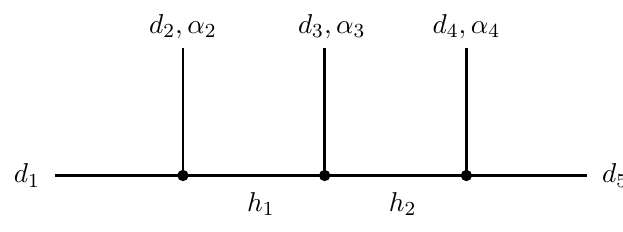
Figure 2 . 5-point superconformal block in the linear